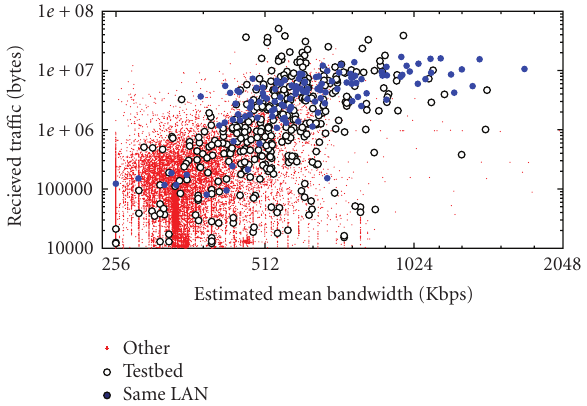
Figure 5: Scatter plot of received tra ffi c versus estimated mean bandwidth (log-log scale).